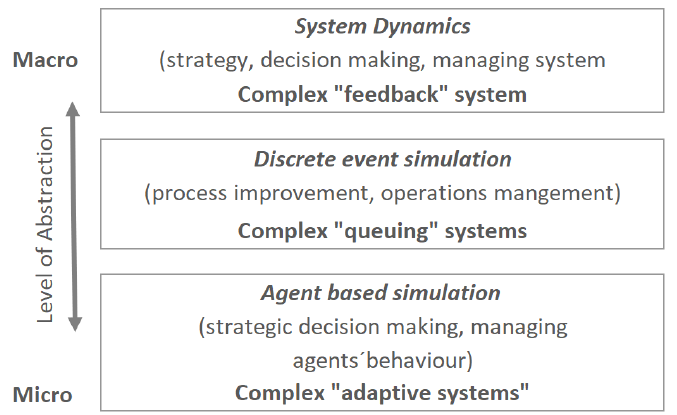
Figure 1. Level of abstraction of different simulation approaches.